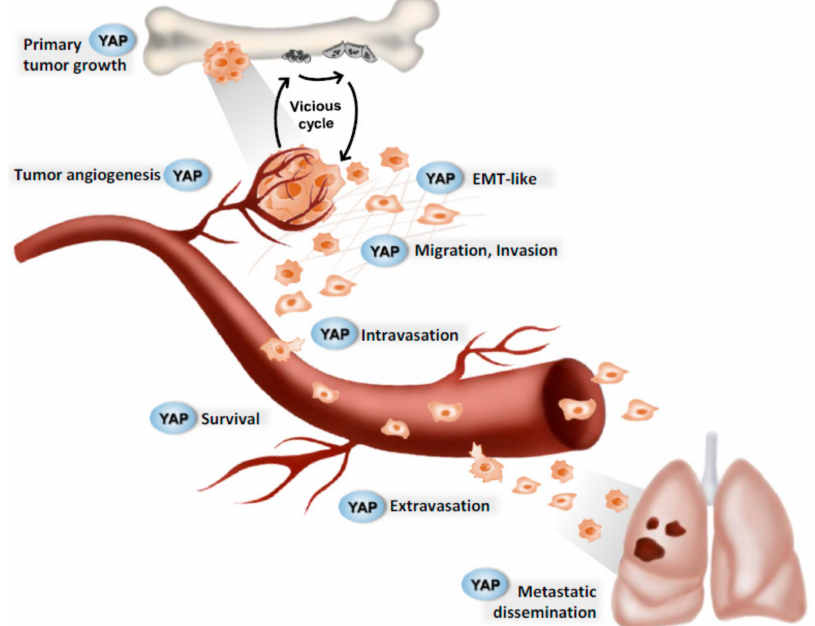
Figure 2. Successive steps in paediatric bone tumour progression. Hypothetical implication of the YAP signaling pathway. YAP (yes-associated transcription factor coactivator) plays a major role at various crucial steps during tumor progression. In pediatric bone tumors, the Hippo signaling pathway may be involved in primary tumor growth, tumor angiogenesis, epithelial-mesenchymal transition, intravasation, extravasation, cell survival, and metastatic